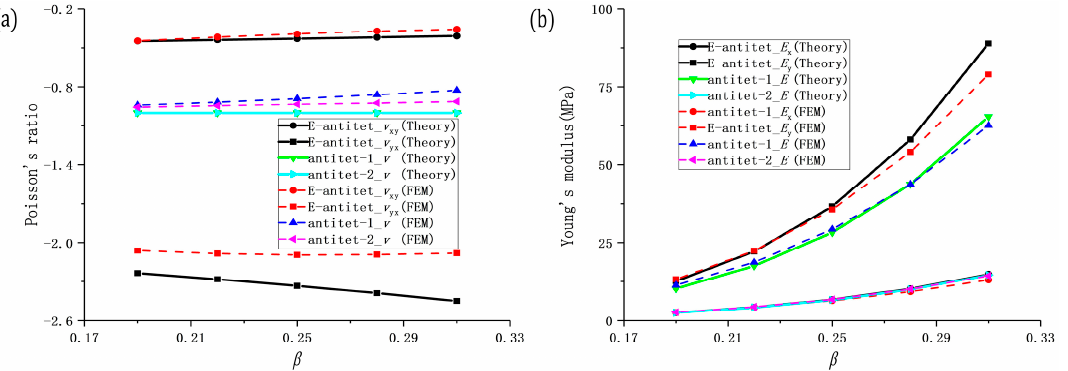
Figure 8. Trends of Poisson’s ratio and Young’s modulus of E-antitet at different 𝛽 : Comparison of the results of analytical and numerical solutions of E-antitet with antitet-1 and antitet-2. ( a ) Poisson’s ratio and ( b ) Young’s modulus.